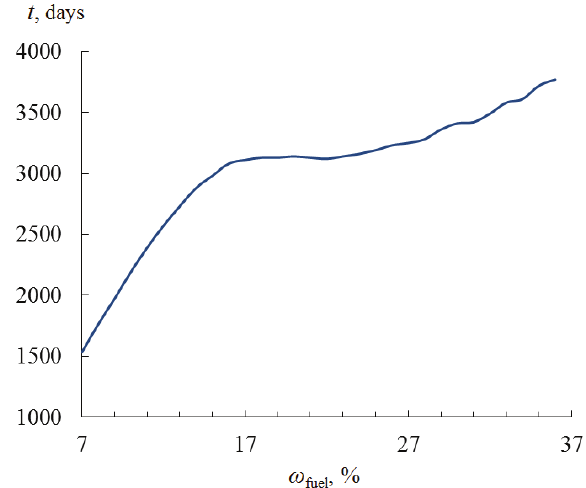
Figure 2. Duration of operation as a function of fraction of dis - persed phase.